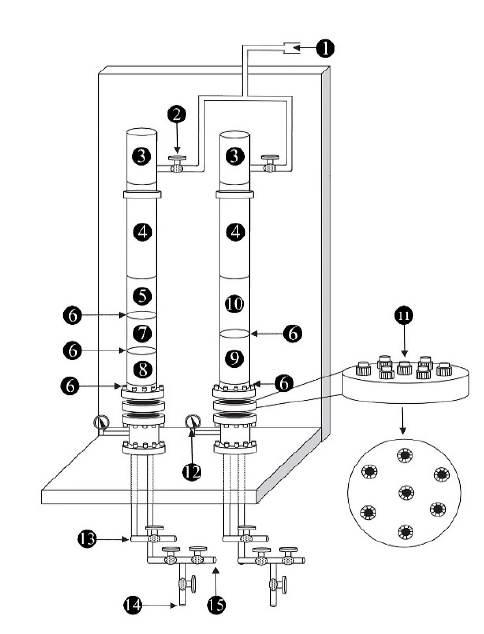
Figure 1. Schematic diagram of the pilot used in this study 1. Effluent of sedimentation unit and water influent;